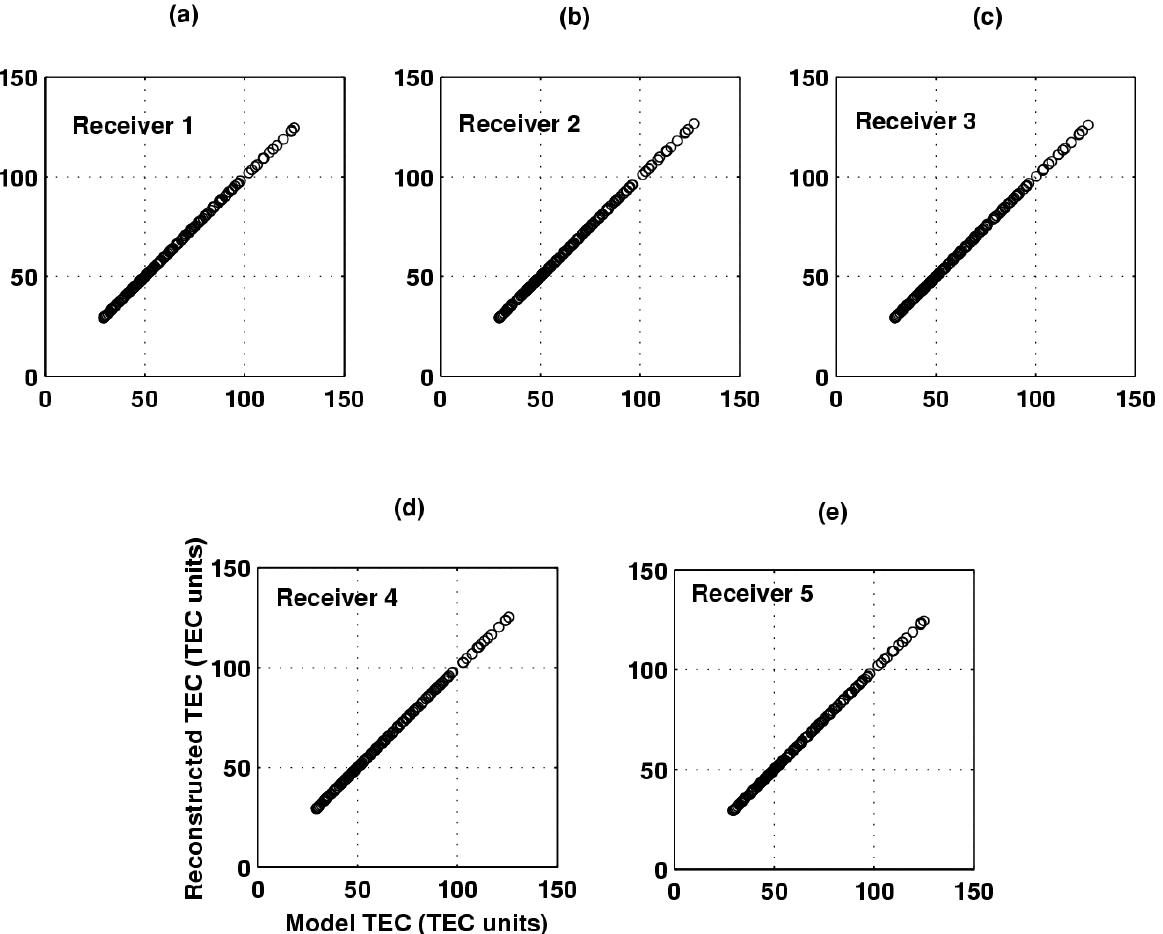
Fig. 3. The input (model) TEC values vs. the reconstructed TEC values for the five receiver